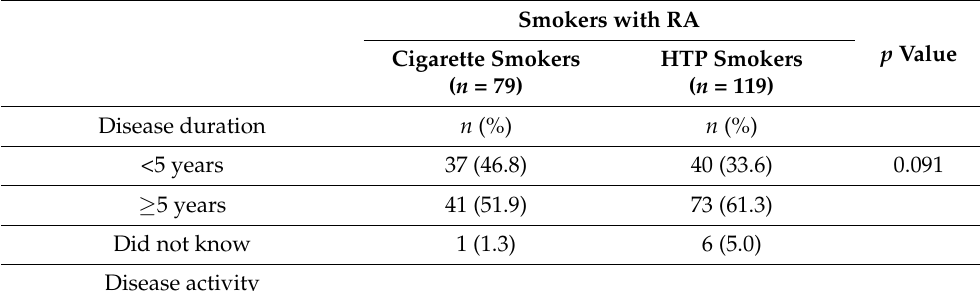
Figure 2. Adjusted ORs of diseases for HTP use with adjustment for age, sex, equivalent household income and residence. ( a ) Adjusted ORs for HTP use including dual use of cigarettes and HTPs. ( b ) Adjusted ORs for dual use of cigarettes and HTPs. HTP: heated tobacco product, OR: odds ratio, CI: confidence interval, RA: rheumatoid arthritis, COPD: chronic obstructive pulmonary disease, AD: atopic dermatitis, CVD: cardiovascular disease. Table 3. Disease information of smokers with RA who completed the secondary